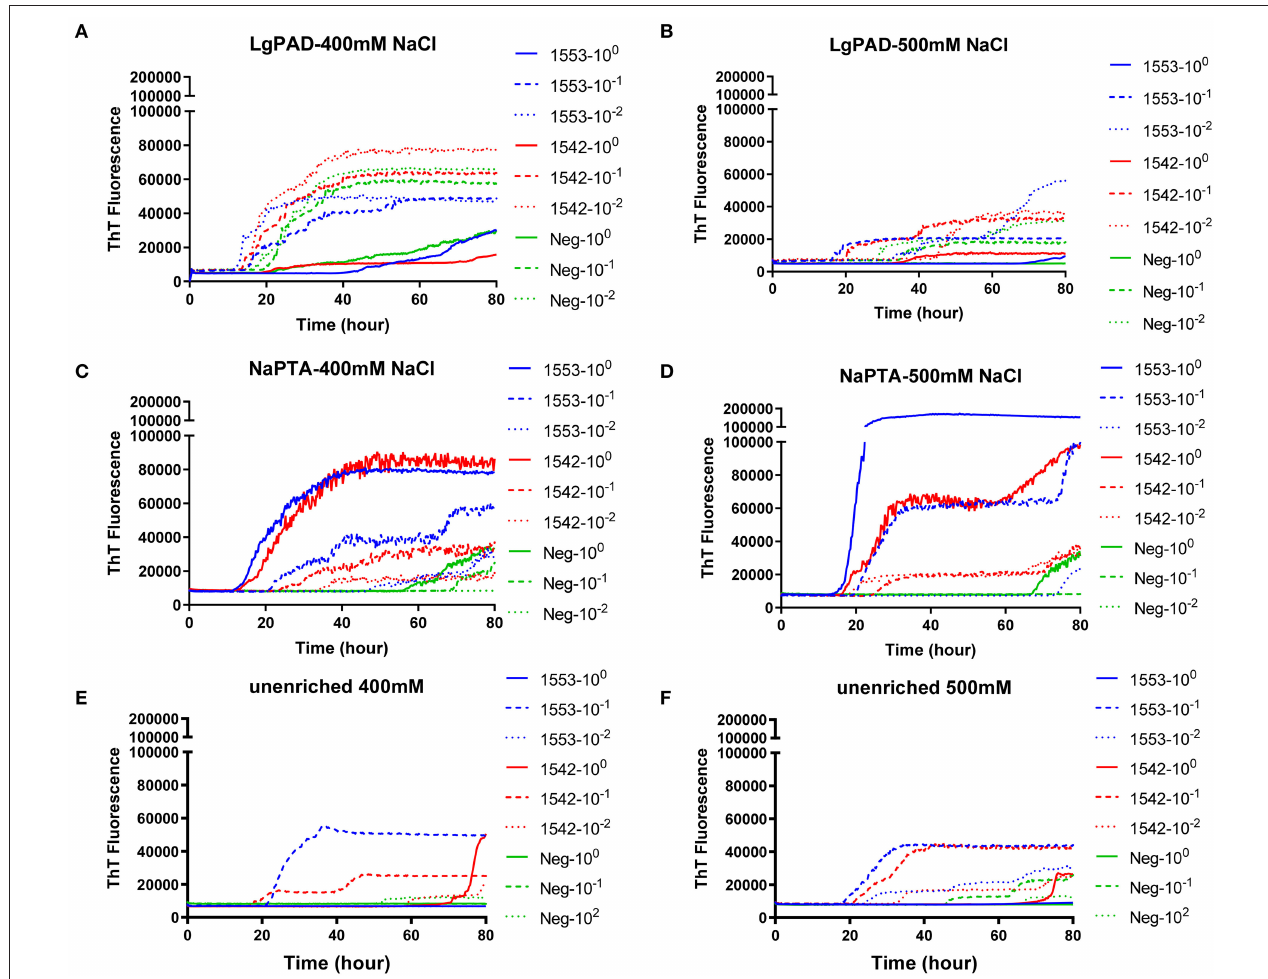
FIGURE 4 | Comparison of RT-QuIC reactions seeded with fecal dilutions from different enrichment. (A,B) enriched with PAD-Beads large scale (C,D) enriched with NaPTA (E,F) non-enriched dilutions. All reactions were seeded with fecal homogenate of white-tailed deer with the addition of 0.001% of SDS. Shown are the average ThT fluorescence readings determined from all replicates (four replicate reactions per each dilution).